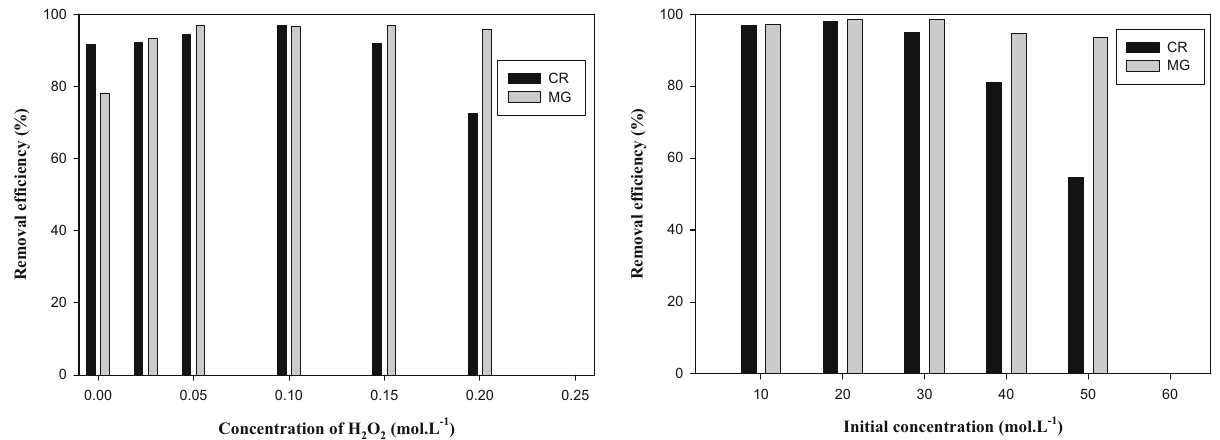
Figure 3: E ff ect of initial concentration on the removal e ffi ciency.